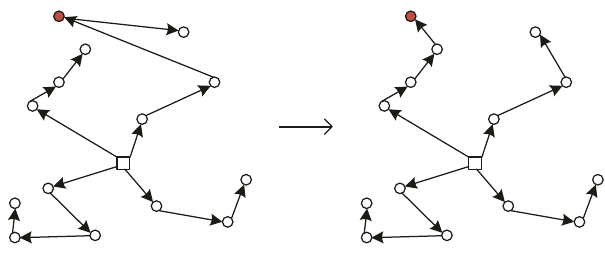
Figure 3: High-cost-node improvement operator. Table 3: Algorithmic parameters